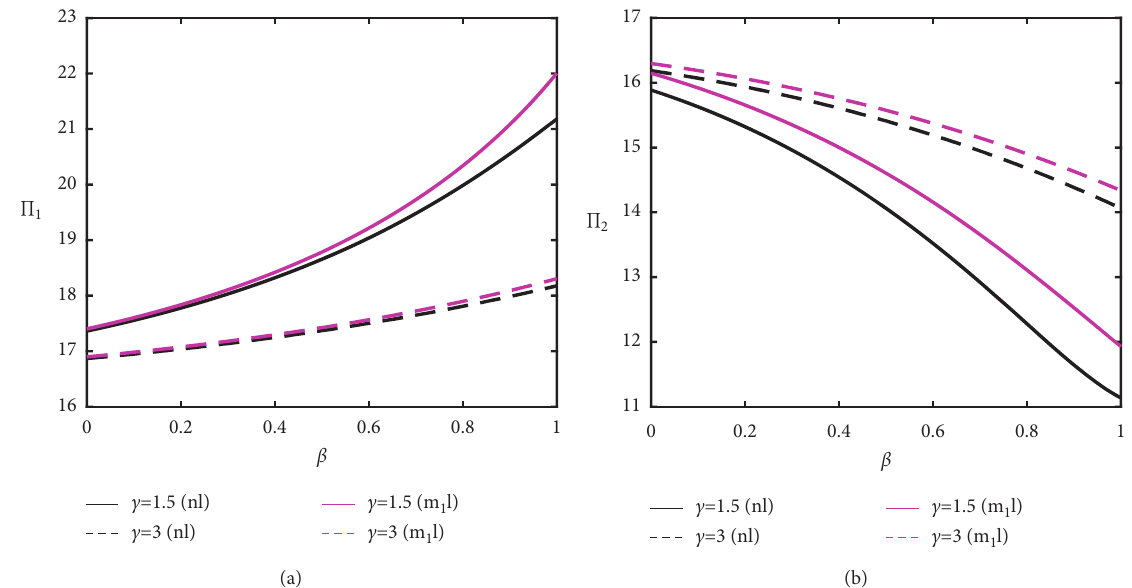
Figure 2: The impact of β and c on profit. (a) The impact of β and c on 􏽑